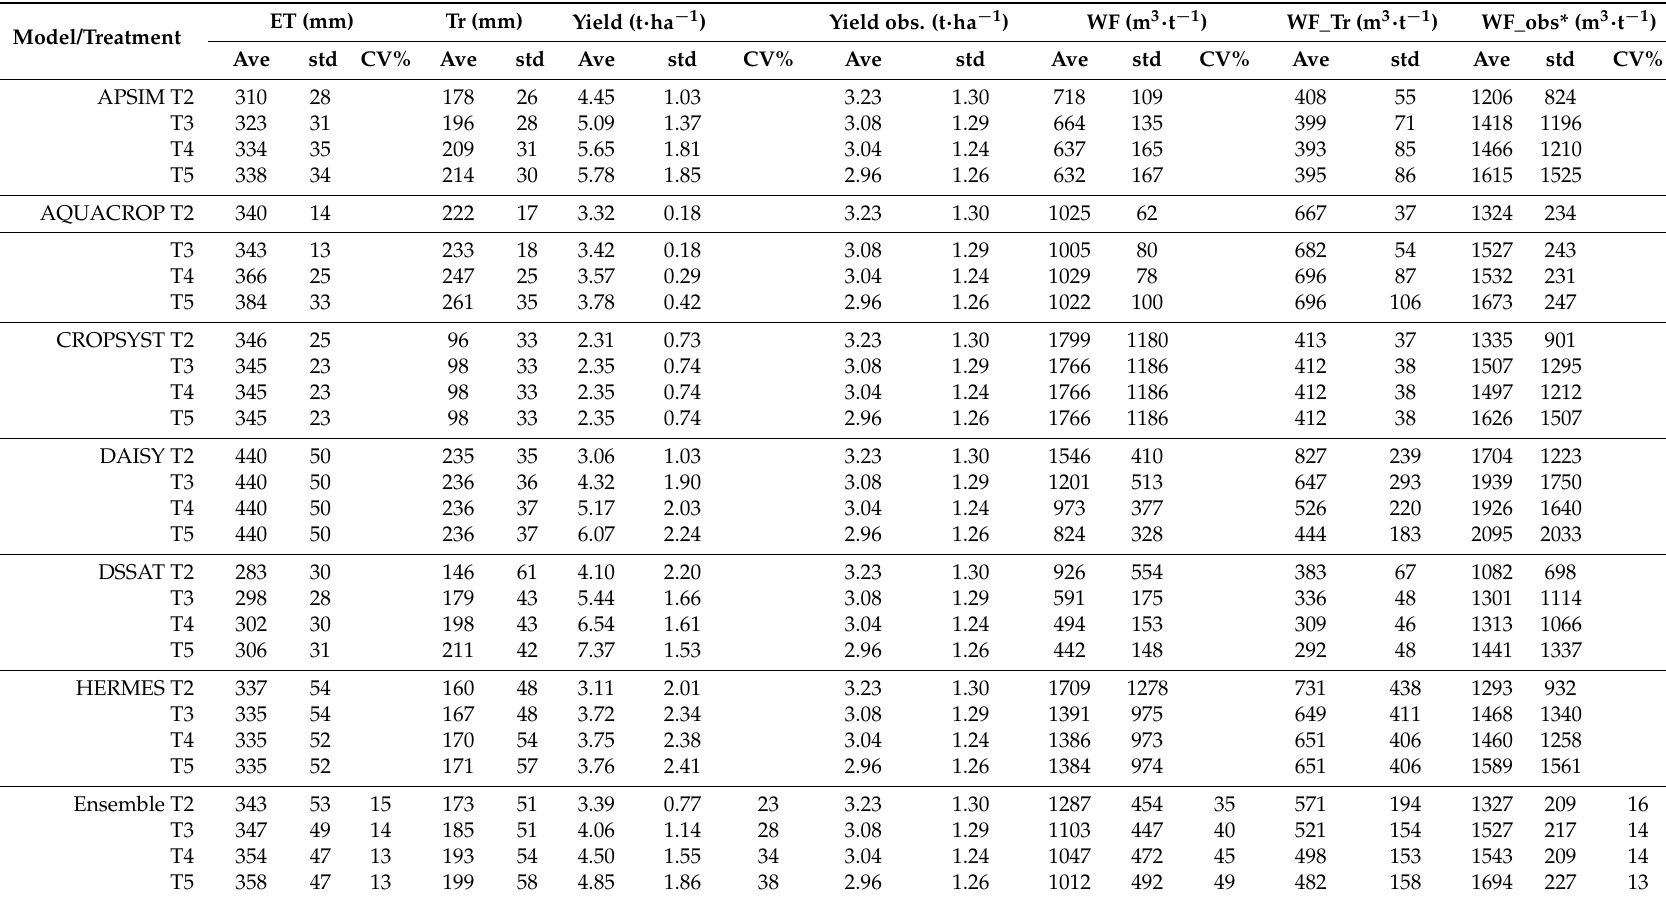
Table 4. Simulated actual evapotranspiration (ET), transpiration (Tr), grain yield (86% d.m.) and resulting water footprints based on ET (WF) and transpiration (WF_Tr) for winter wheat for four treatments at Foggia/Italy from different models. WF_obs* indicate water footprints based on simulated ET and measured yields. Ave is the average value, std indicates the standard deviation and CV% the coefficient of variation in percent (only for the ensemble mean).